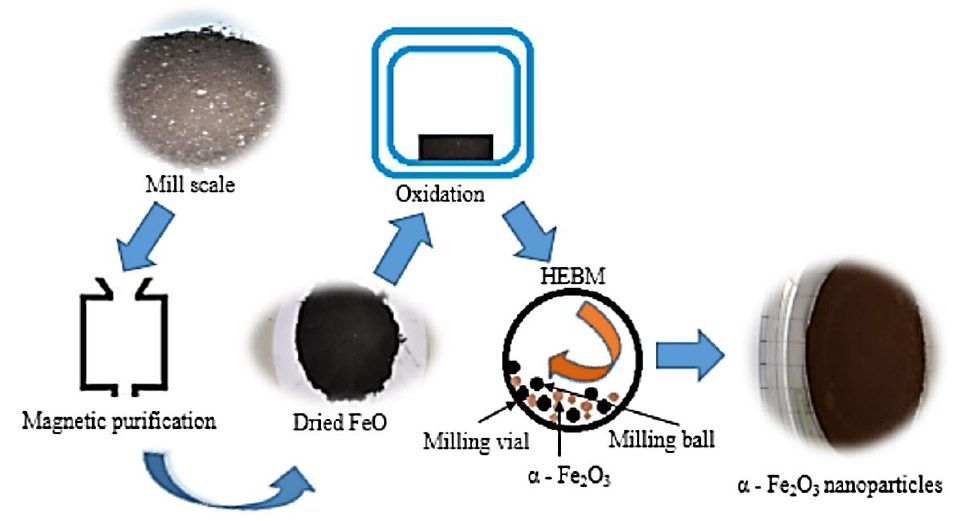
Figure 1. Synthesis of recycled α -Fe 2 O 3 nanoparticles.